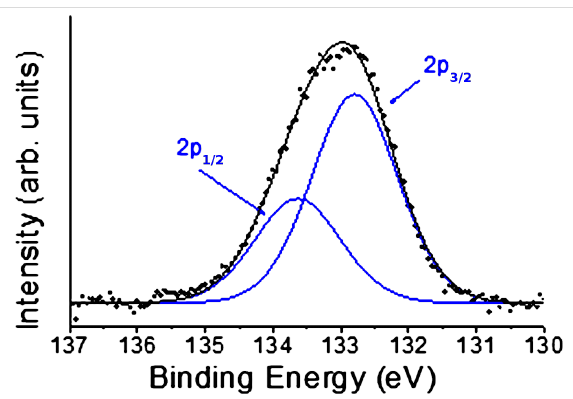
Figure 2: Fitting of the XPS spectrum characteristic of P collected on GPs-Nit-PO 9 showing the two components (2p 1/2 and 2p 3/2 ) relative to the phosphine oxide group (for XPS spectra of the other com- pounds see Supporting Information File 1).